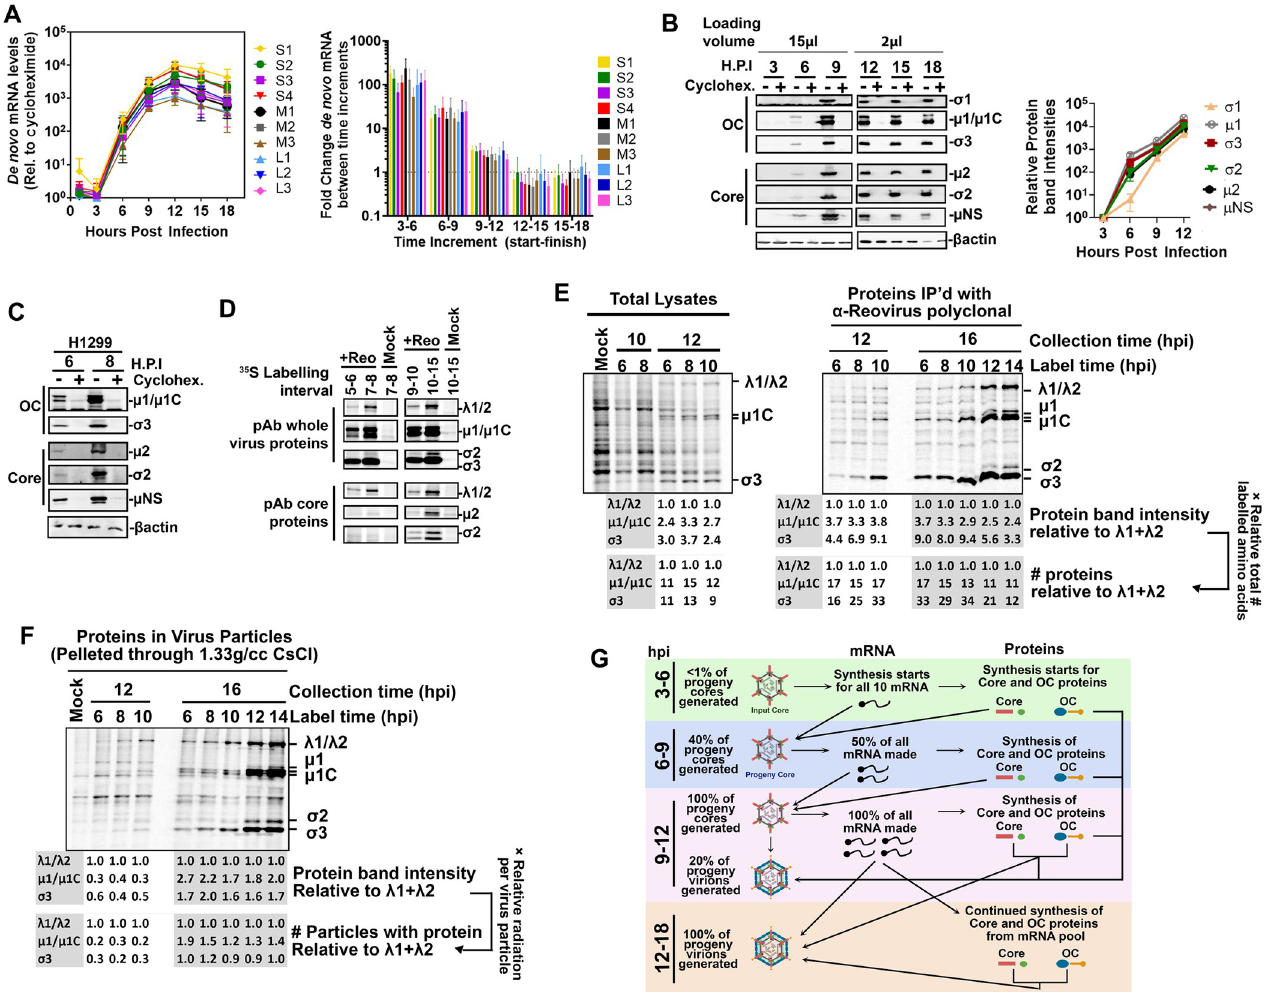
Fig 2. Reovirus RNAs and proteins are generated simultaneously. (A-B) L929 cells were infected with reovirus at an MOI of 3 with or without cycloheximide (100 μ g/mL) and samples were collected every 3 hours to measure virus mRNA and protein levels. (A, Left) De novo mRNA levels by RT-qPCR at each time point for the indicated reovirus transcripts, calculated as fold-increase in cycloheximide-treated over mock-treated samples for each timepoint, n = 4. (A, Right) Fold increase in de-novo virus mRNA among the time intervals indicated, n = 4. (B, Left) Representative blots show de novo virus protein levels by SDS-PAGE and Western blot analysis using polyclonal antibodies raised against whole virus (detects μ 1c and σ 3), μ 2, σ 2, or μ NS, or the σ 1 N-terminal domain as indicated. (B, Right) Combined protein levels for n = 4. Statistical analysis was performed by two-way ANOVA for A and B, but no significant differences were found. (C-D) H1299 cells were infected with reovirus at an MOI of 3. (C) Similar to B but in H1299 cells. (D) H1299 cells infected with reovirus radio- labelled with S 35 -methionine/cysteine for the indicated time increments and then immediately lysed. Lysates were subjected to immunoprecipitation with either polyclonal antibodies from rabbits exposed to whole reovirus (pAb whole virus proteins) that predominantly recognize OC μ 1c and σ 3 but also core proteins λ 1/2, or polyclonal antibodies from rabbits exposed to reovirus cores (pAb core proteins) that predominantly recognize core proteins σ 2, μ 2 and λ 1/2. Mock infected cells were used as negative controls. (E-F) H1299 cells infected with reovirus (or mock) were pulse-labelled with S 35 -methionine/cysteine at the indicated time (label time) for 30 minutes and then chased with normal media until the indicated collection time. (E, Left) Whole lysates show pulse-labelled virus and host proteins. (E, Right) Whole lysates were subjected to immunoprecipitation with polyclonal anti-reovirus antibodies prior to electrophoresis. (F) Whole lysates were subjected to high-speed ultracentrifugation through 1.33g/cc CsCl to pellet reovirus cores and fully-assembled viruses. Minimal host protein contamination is demonstrated by the mock control. (G) Using values from Figs 1 and 2, summary of de-novo mRNA, proteins, progeny cores, and progeny infectious viruses is presented during the course of one reovirus round of replication. Statistical analysis by ANOVA, ���� p < 0.0001, ��� p < 0.001, �� p < 0.05, ns >